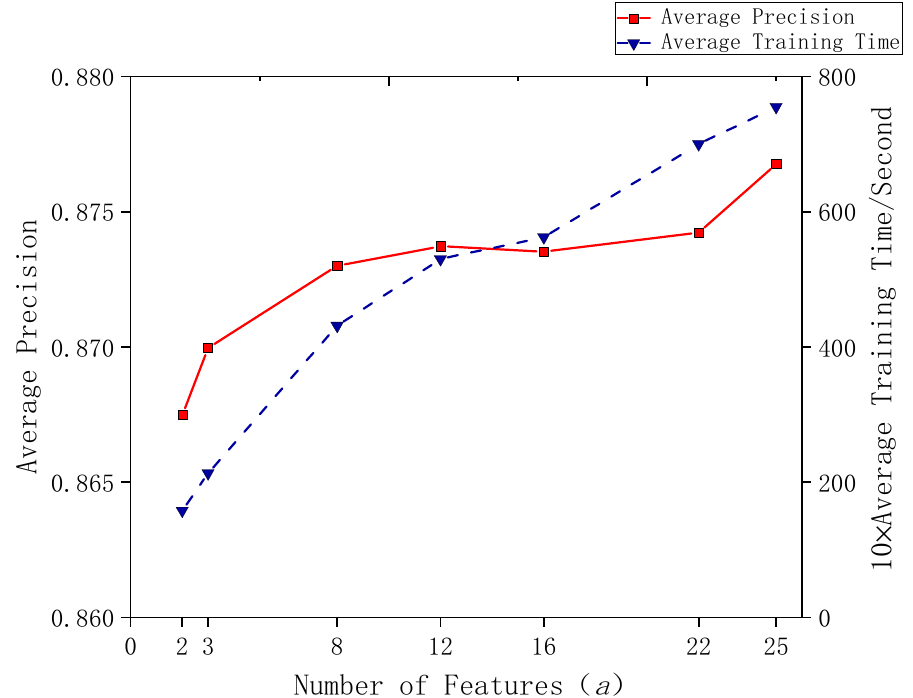
Figure 5. Average accuracy and training time of RSFCF over Small60 datasets under different settings of parameter a .